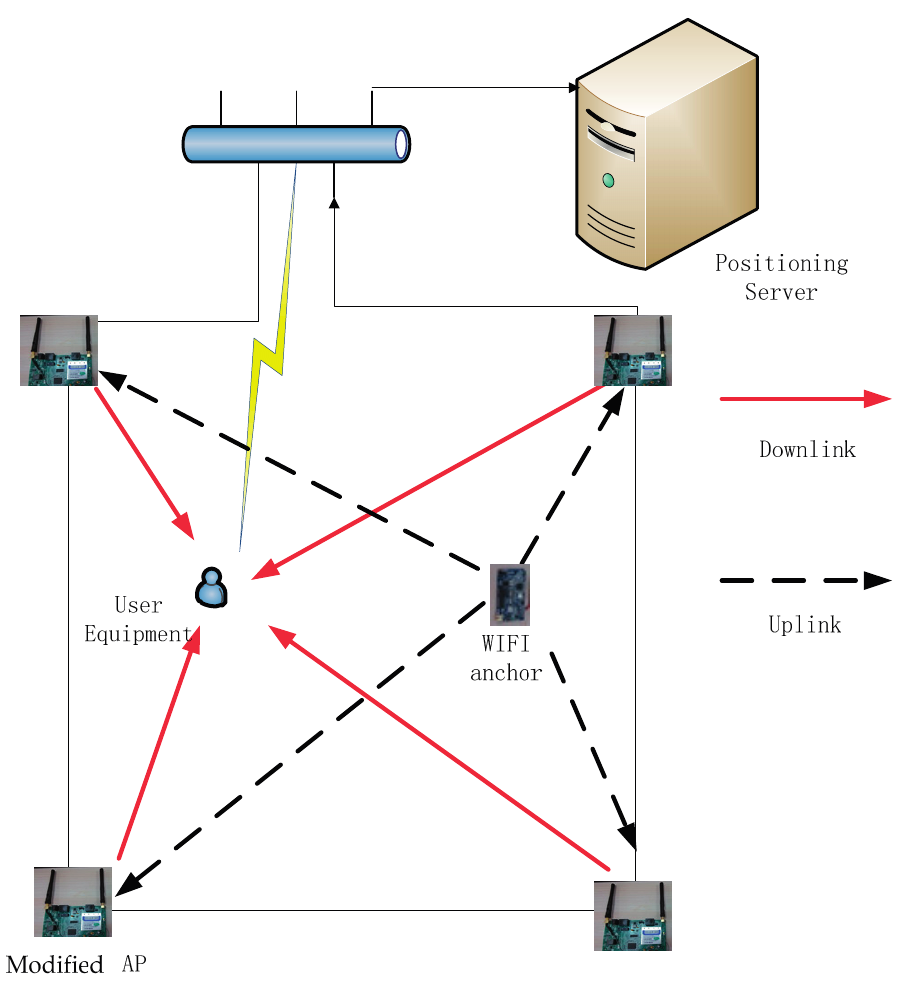
Figure 1. Improved WIFI positioning